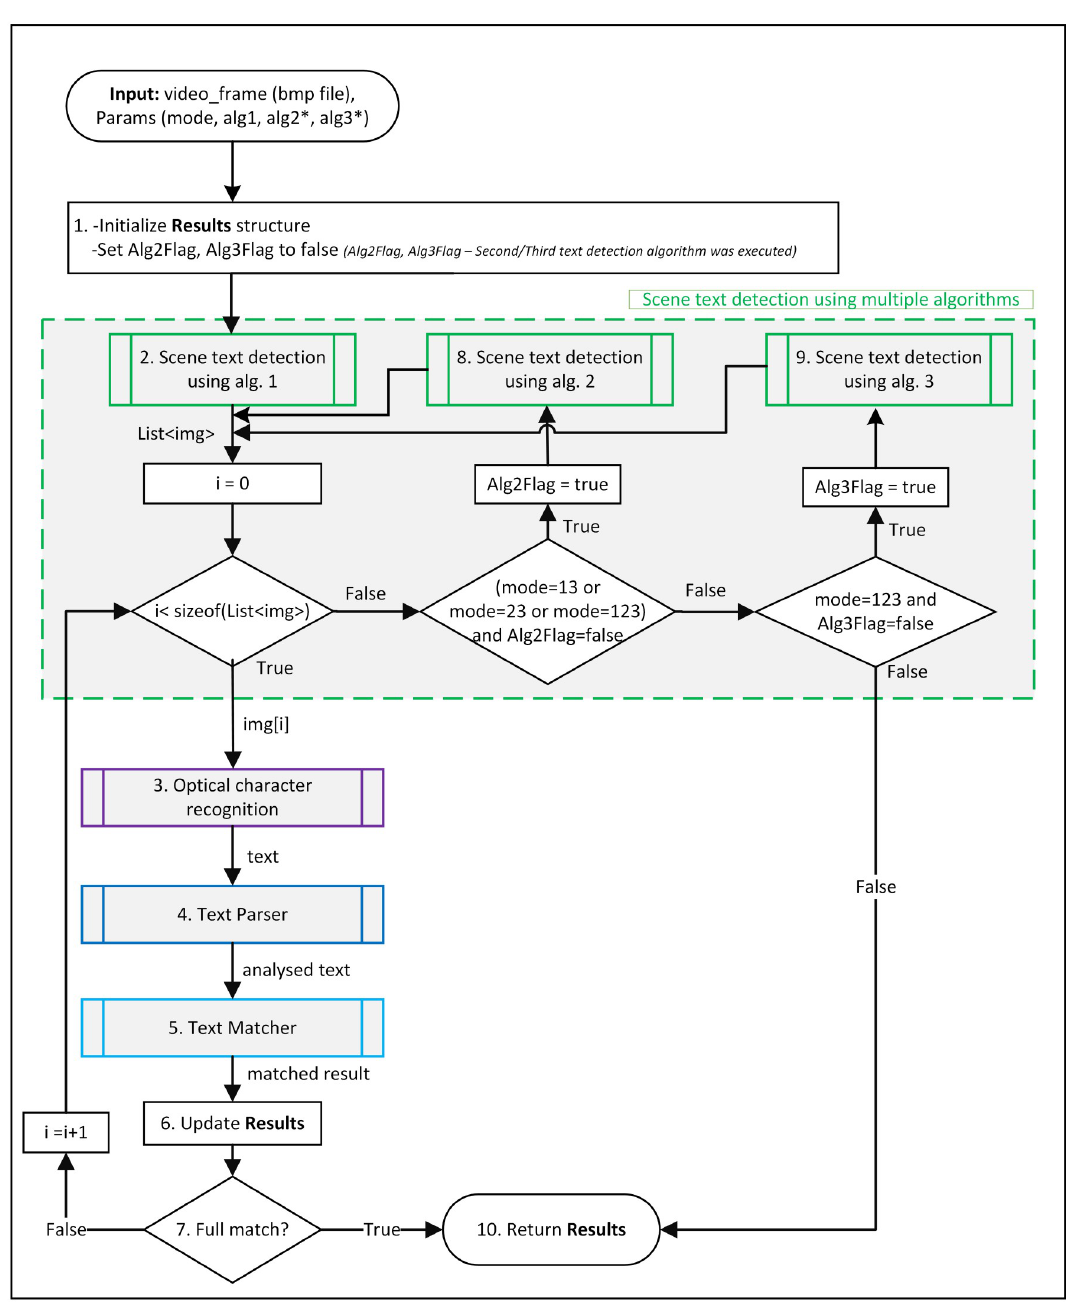
Fig 3. General scheme of vessel identification